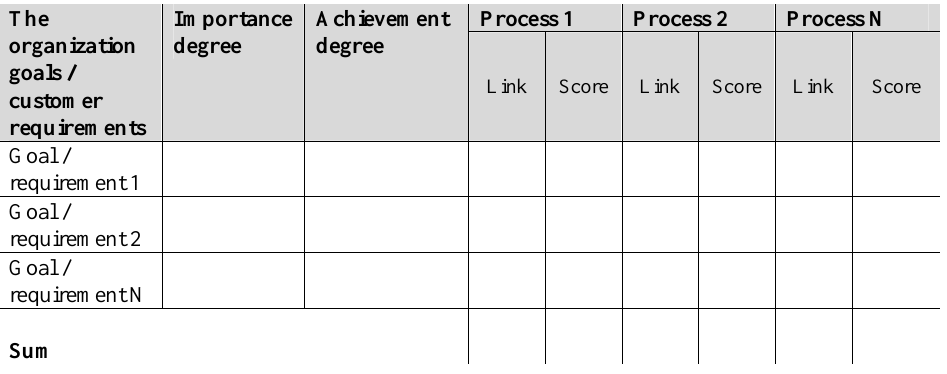
Table 2 – Selection of processes for